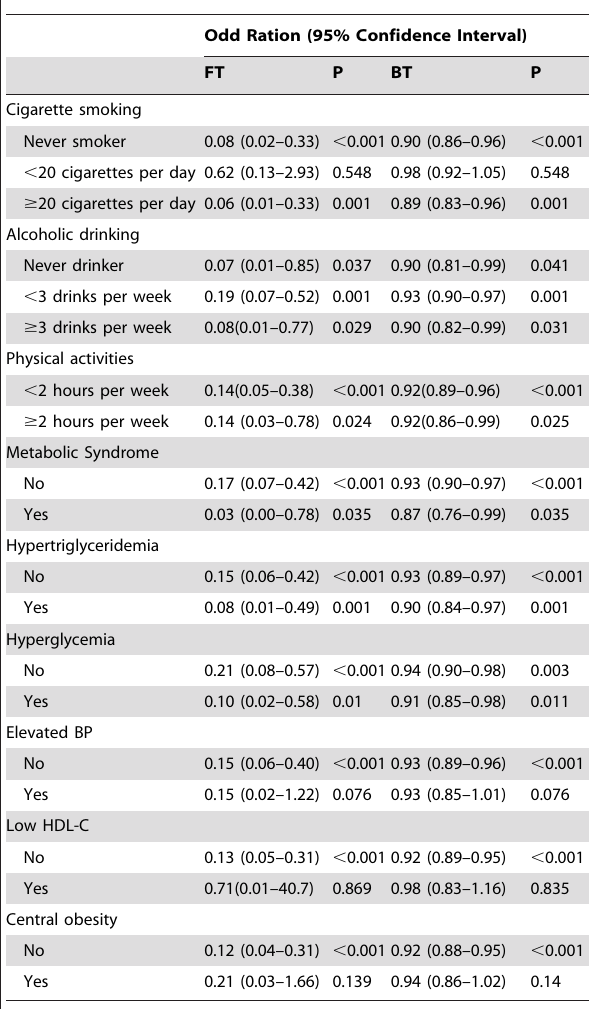
TT=total testosterone, FT=free testosterone, BT=bioavailable testosterone, SHBG=sex hormone-binding globulin, BP=blood pressure, HDL-C=high- density lipoprotein cholesterol.